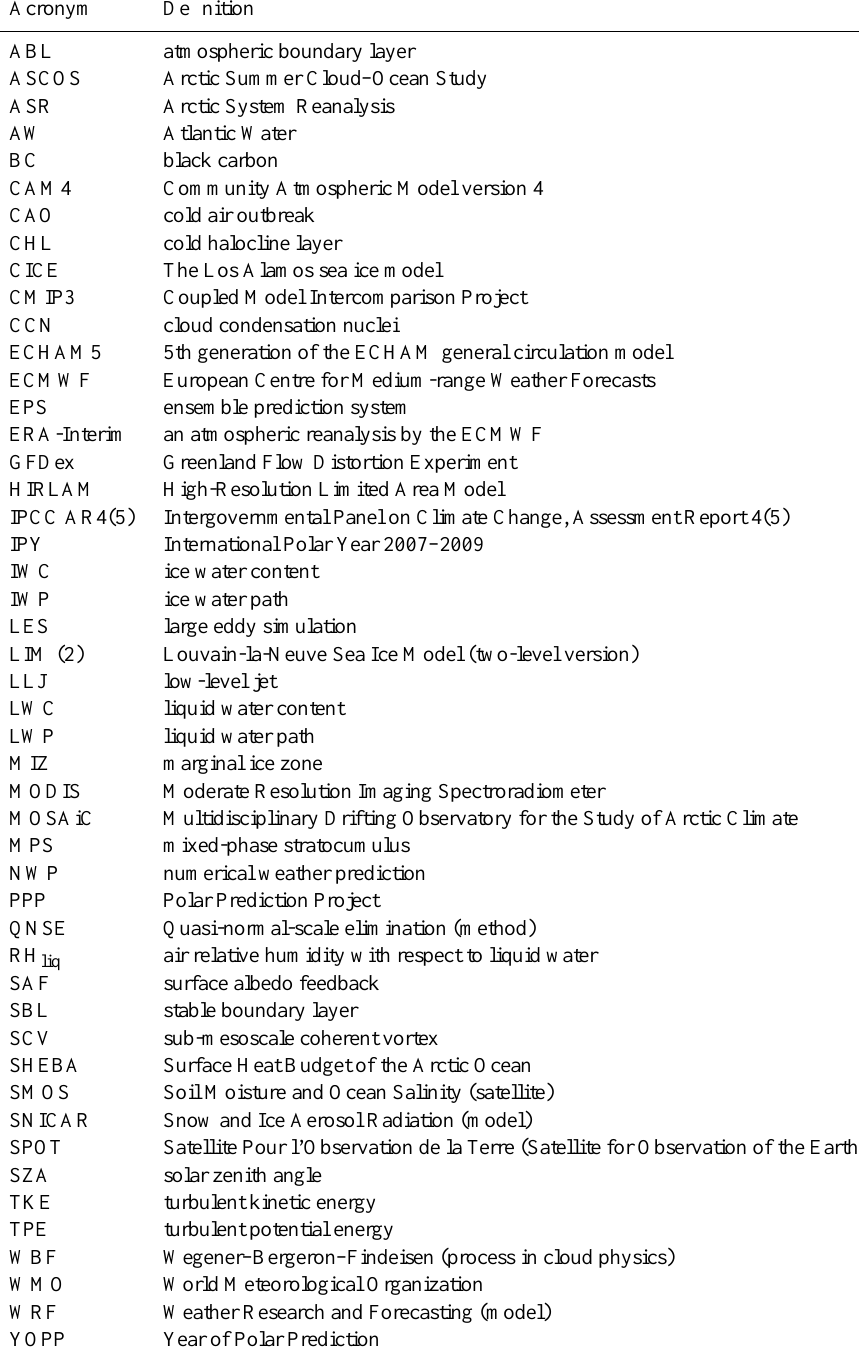
Table A1. List of